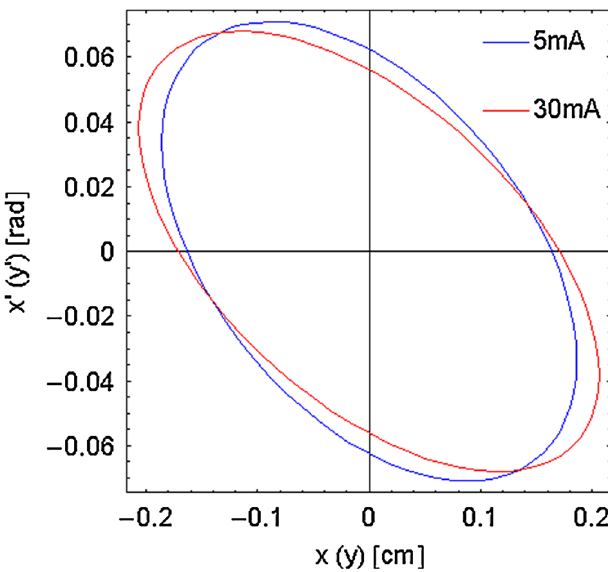
FIG. 5. (Color) Input emittance ellipses for 5 and 30